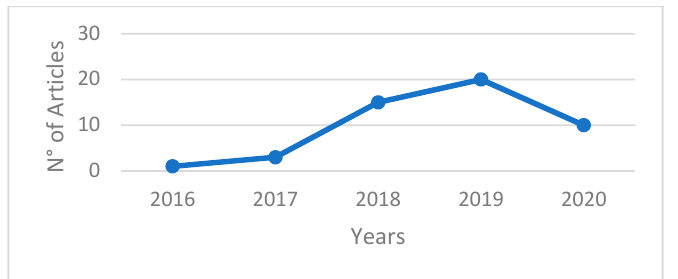
Figure 2. Publications distribution per years.